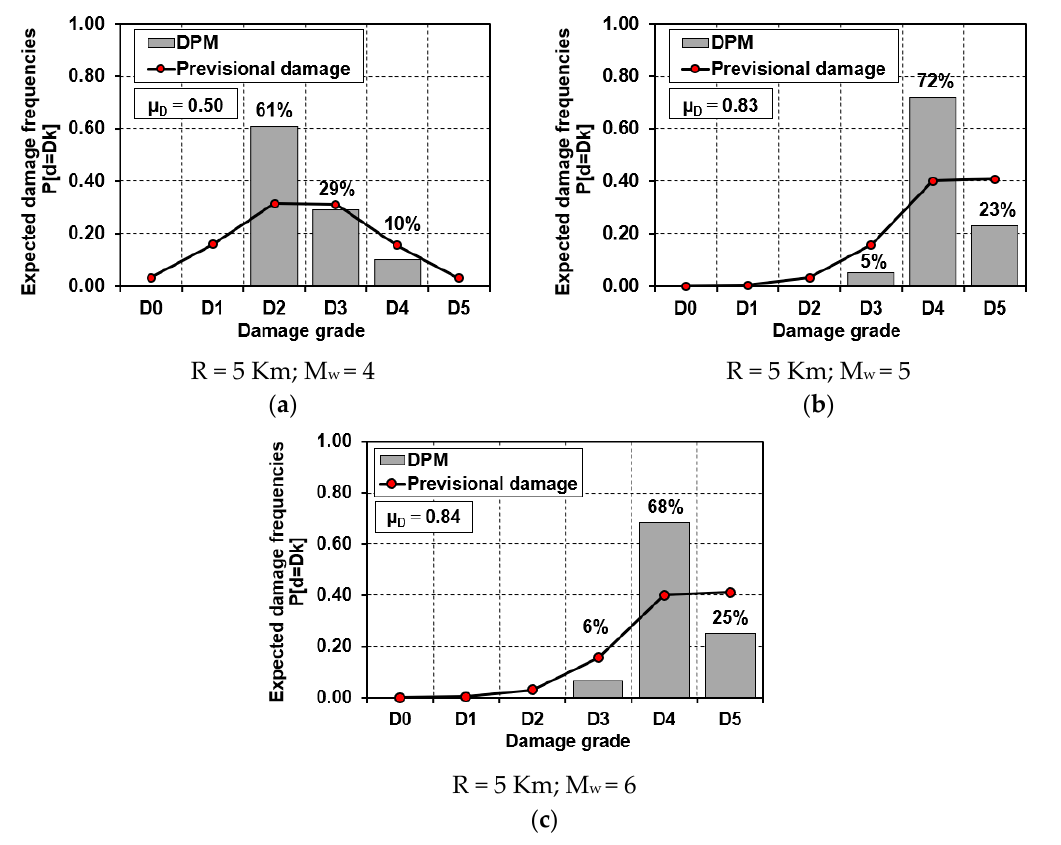
Figure 15. Damage distribution in the urban sector under investigation.